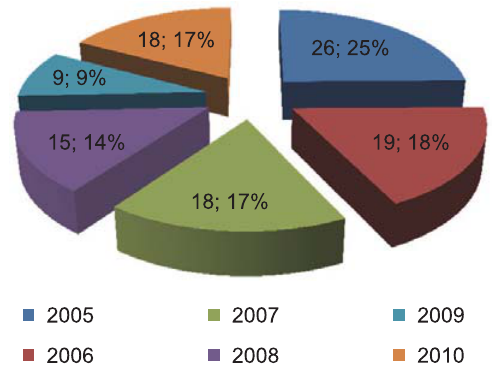
FIGURE 2. Annual average concentration of NO2 automatic